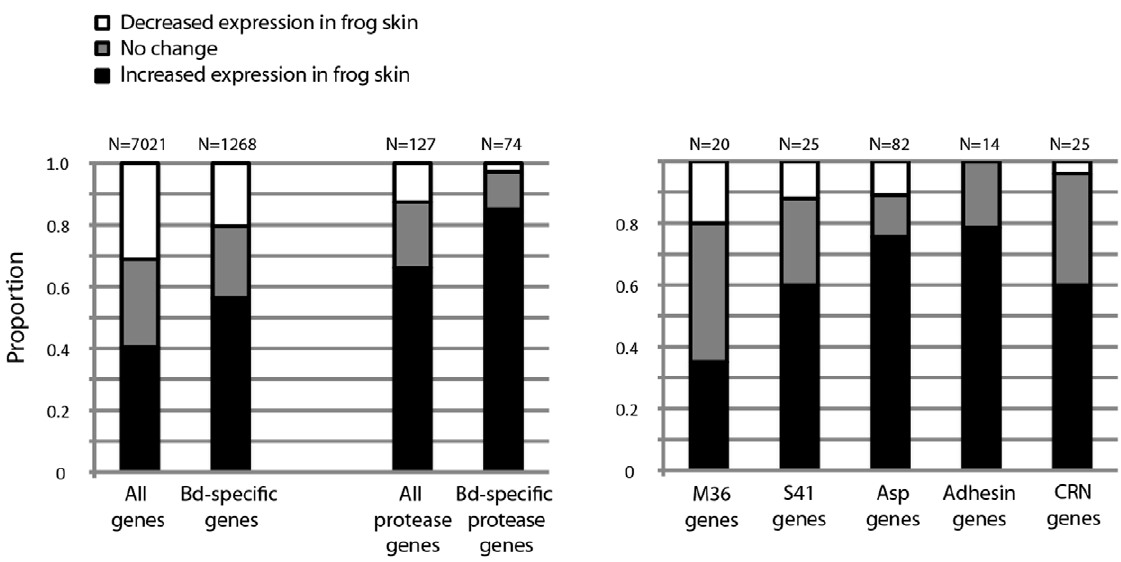
Figure 1. The proportion of Bd genes with significantly increased or decreased expression in the frog skin treatment (relative to the tryptone treatment) shown for all genes, Bd-specific genes, and several families of putative pathogenicity genes. Genes with significant differences in expression were identified using a correction for multiple testing. Abbreviations include M36=fungalysin metalloprotease, S41=serine protease, Asp=aspartyl protease, CRN=Crinkler-like effectors.